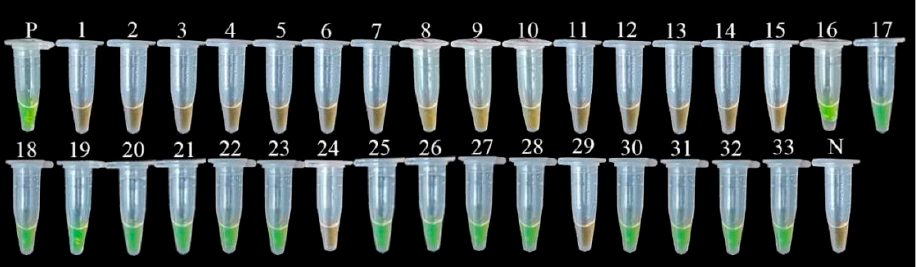
Figure 10. The feasibility detection of the LAMP assay. Note: 1–5: Soil DNA of healthy plant roots in the experimental plot 1; 6–11: Soil DNA of healthy plant roots in the plot 2; 12–15: Soil DNA of healthy plant roots in the plot 3; 16–17: Soil DNA of diseased plant roots in the plot 3; 18–23: Soil DNA of diseased plant roots in the plot 4; 24: control root-soil DNA; 25–28: diseased soil DNA; 29: back-linked control kiwi plant root DNA; 30–33: DNA from the root of diseased kiwifruit; P, positive control strain; N, negative control.